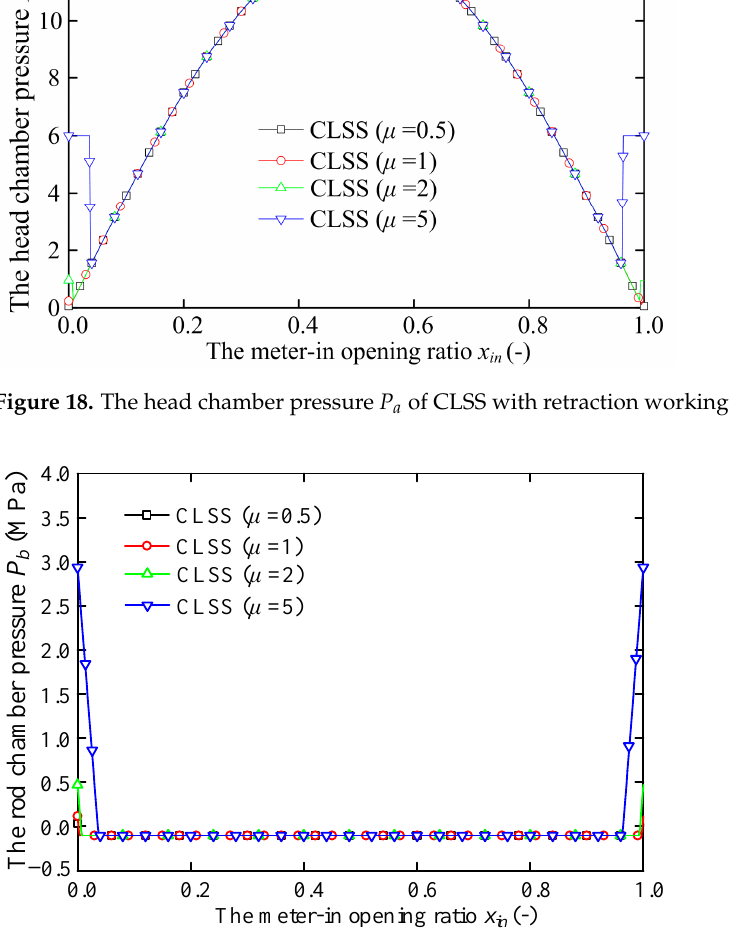
Figure 20. The flow rate Q a of the cylinder head chamber of CLSS with retraction working mode.